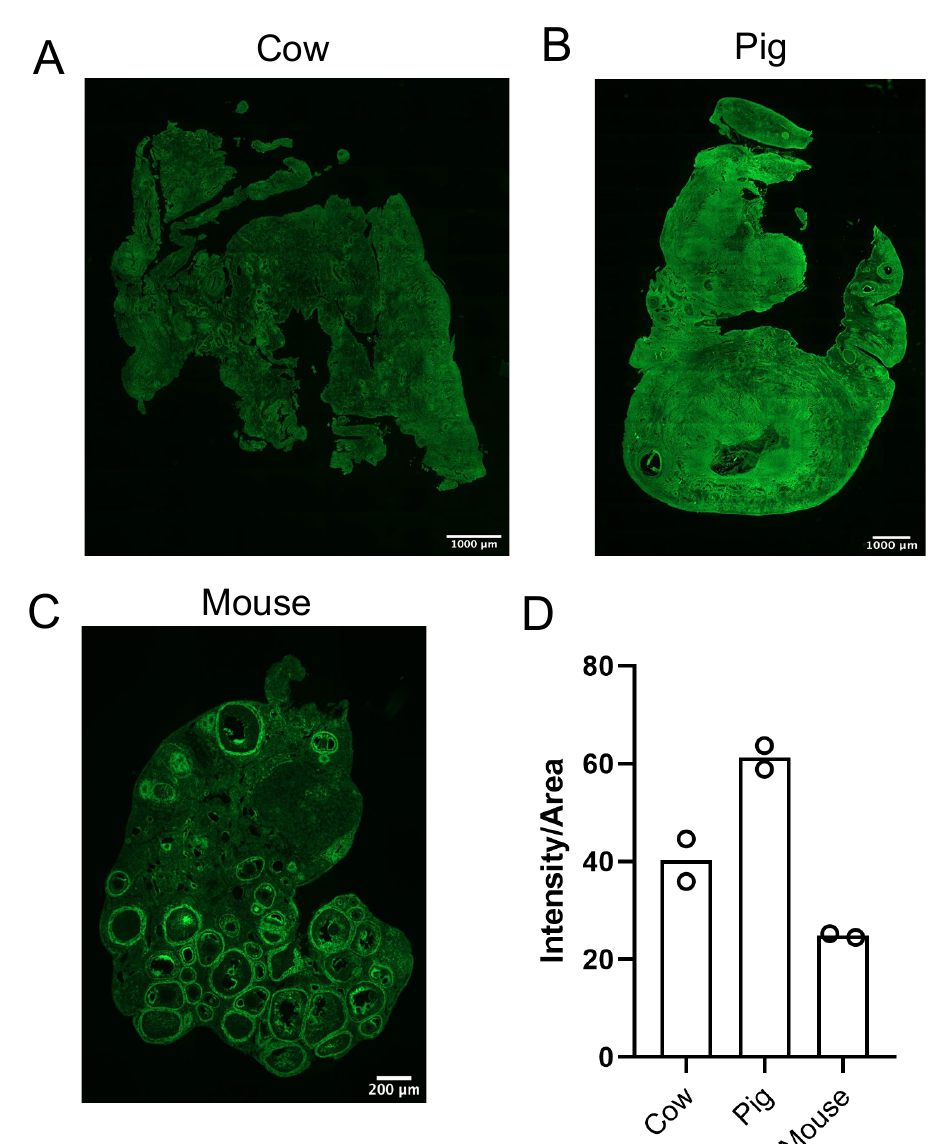
Figure 6. Hyaluronan content in cow, pig, and mouse ovaries. HABP assay was used to detect HA (green) in ( A ) cow, ( B ) pig, and ( C ) mouse ovaries. ( D ) Graph showing HA intensity per area in cow, pig, and mouse ovaries. Circles represent values from individual animals. The scale bars are 1000 µ m ( A , B ) and 200 µ m ( C ). Images are representative of bovine ( n = 2 cows, n = 1 ovary/cow, n = 4 sections/ovary) porcine ( n = 2 pigs, n = 2 ovaries/pig, n = 2 sections/ovary) and mouse ( n = 2 mice, n = 1 ovary/mouse, n = 4 sections/ovary)